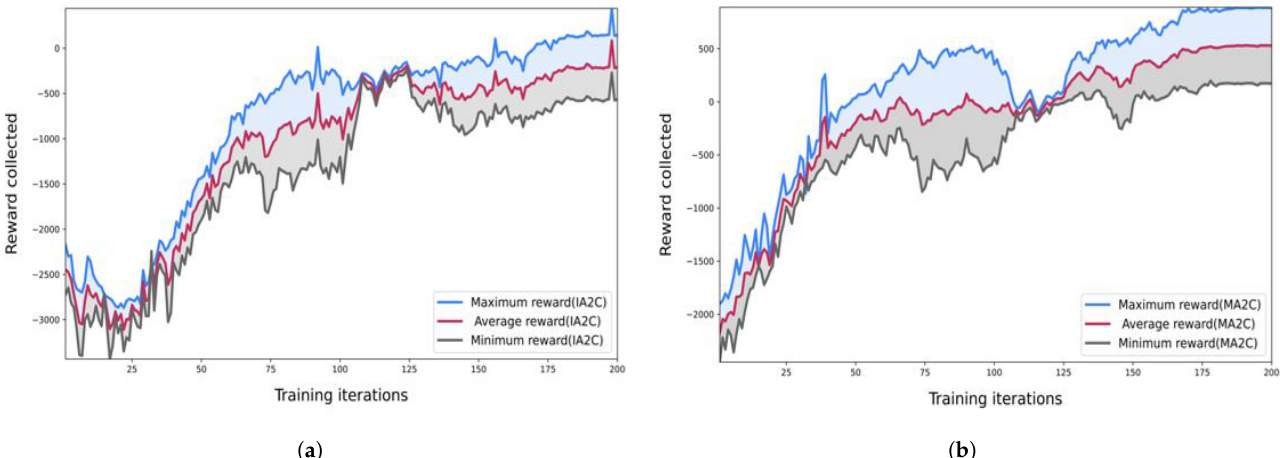
Figure 6. Results of maximum reward comparisons for IA2C and MA2C. ( a ) Maximum reward comparisons for IA2C. ( b ) Maximum Reward Comparison